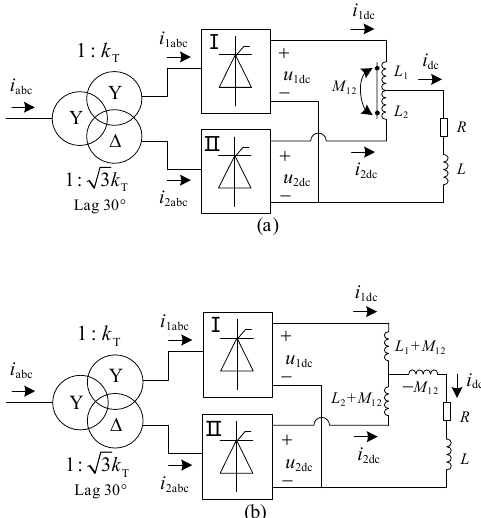
Figure 1. Circuits of a parallel 12 ‐ pulse rectifier: ( a ) equivalent circuit of a parallel 12 ‐ pulse rectifier; ( b ) interphase transformer (IPT) decoupled equivalent circuit of a parallel 12 ‐ pulse rectifier. In Figure 1a, the inductances on both sides of the balanced reactor are L 1 and L 2, and the mutual inductance is M 12. After decoupling the balanced reactor, the equivalent cir ‐ cuit of the parallel 12 ‐ pulse rectifier in Figure 1b is obtained. Compared with the deriva ‐ tion process of the series 12 ‐ pulse rectifier [19], Figure 2 shows the decoupling process of IPT and the calculation of the DC current of each rectifier bridge, which is required to analyze the parallel 12 ‐ pulse rectifier.